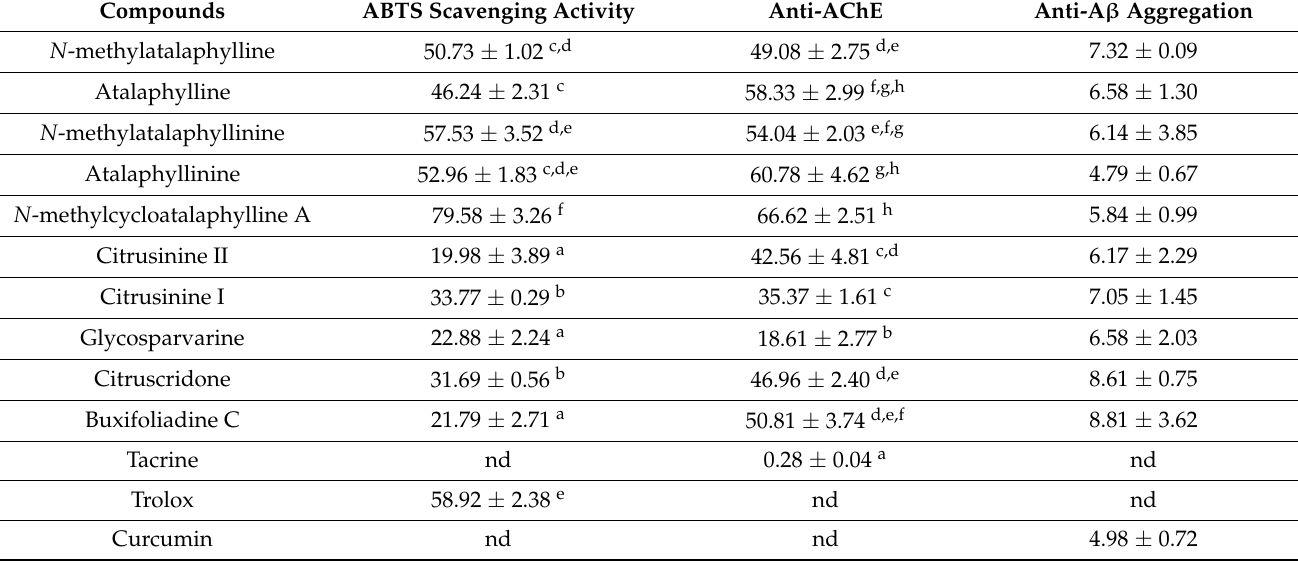
Table 2. The IC 50 ( µ M) of ABTS radical scavenging, AChE, and A β aggregation inhibitory activities by